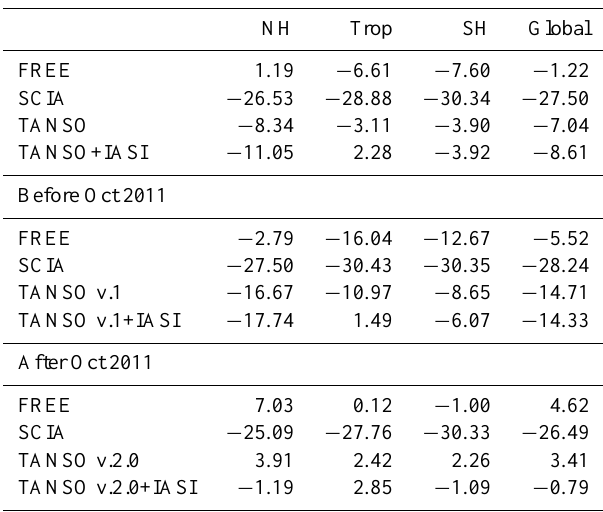
Table 3. Average difference (in ppb) between the free run or the analyses and the TCCON data. The average is computed for all available TCCON stations and split into regions as for Table 1 and into periods: from November 2010 to April 2012 (top block), be- fore October 2011 (middle block) and after October 2011 (bottom block).